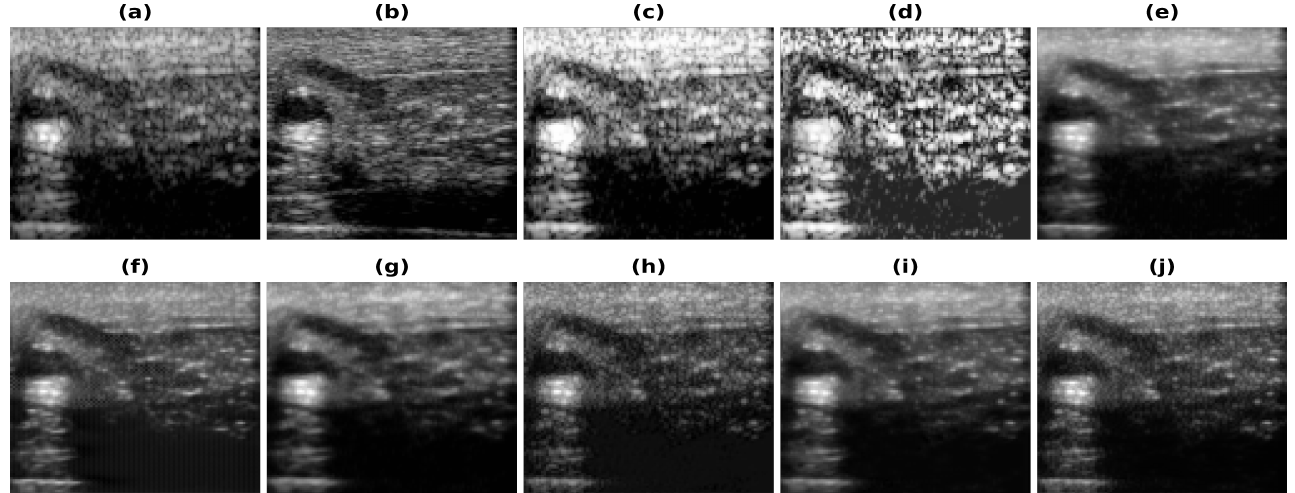
Figure 8. Results of the bandwidth improvement for in vivo carotid mimicking setup for different models ( a ) Band-limited image ( b ) Full Bandwidth image ( c ) Histogram Equalization ( d ) Contrast Limited Adaptive Histogram Equalization ( e ) U-Net-PL1 ( f ) U-Net-PL2 ( g ) SRCNN-PL1 ( h ) SRCNN- PL2 ( i ) REDNet-PL1 ( j )